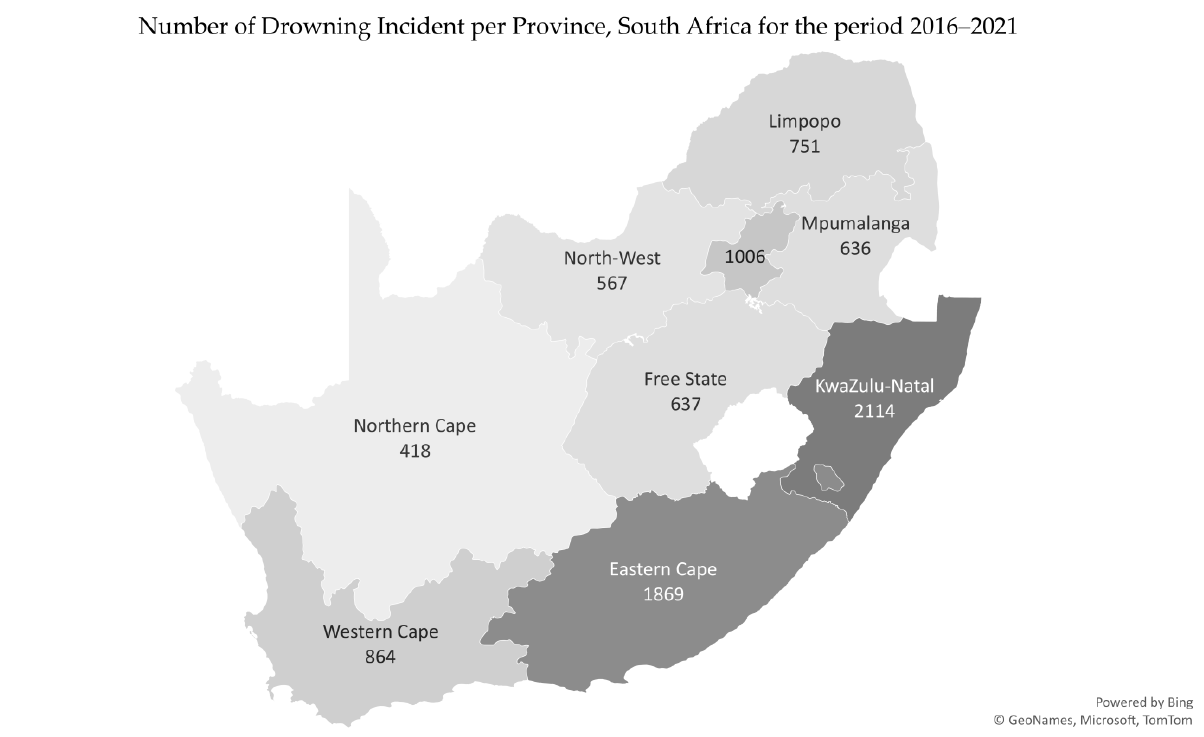
Table 1. Drowning mortality rates per annum in South Africa, 2016 – 2021.